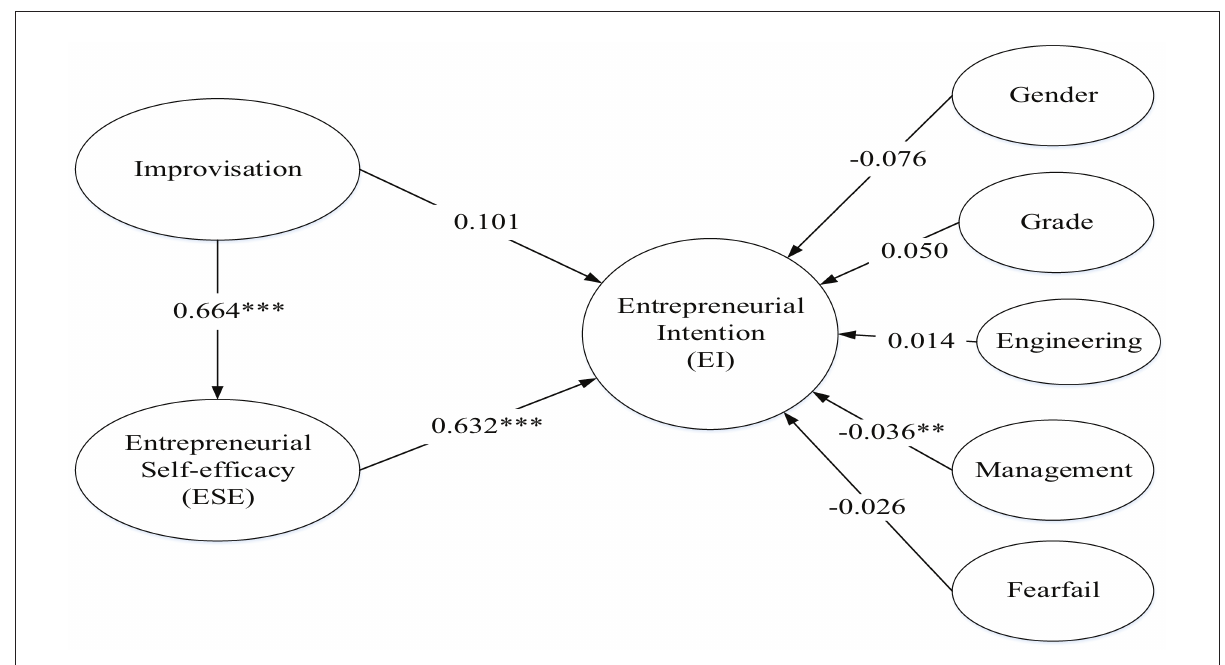
FIGURE 2 The analysis of mediation effect based on structural equation modeling.